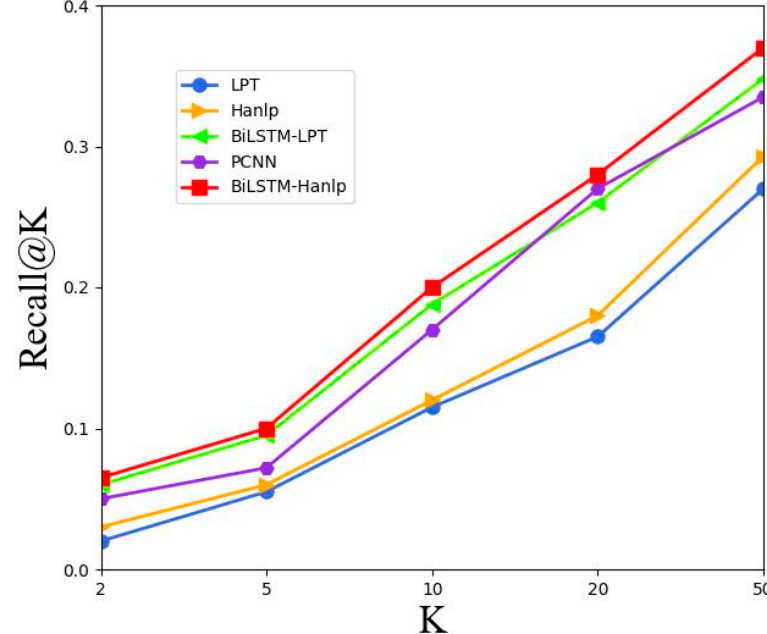
Figure 7. Named entity recognition results based on Recall@K.